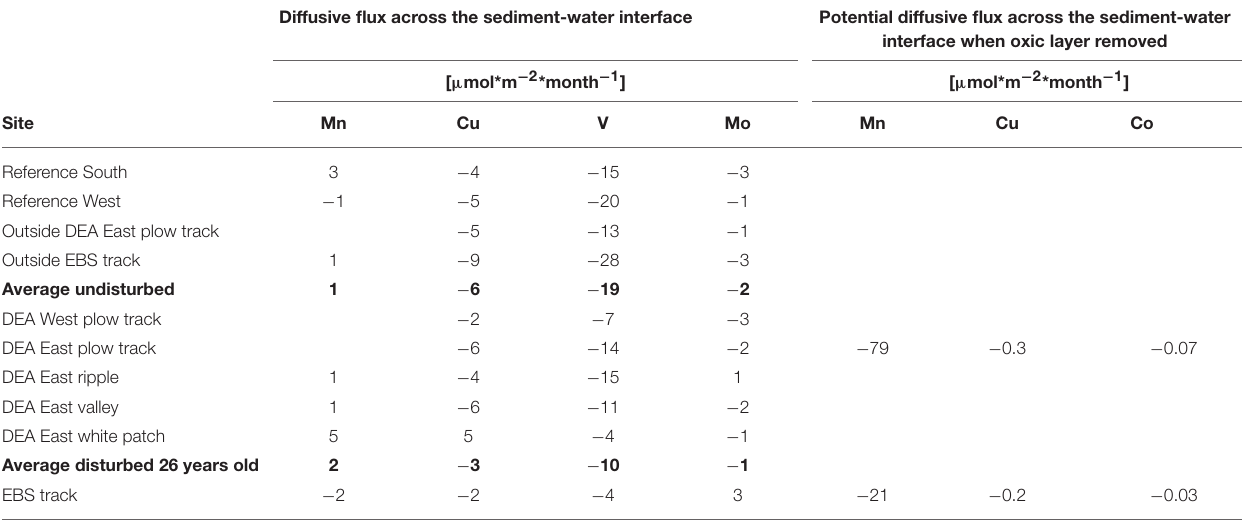
TABLE 3 | Diffusive fluxes of selected dissolved metal ions across the sediment-water interface and potential fluxes across the sediment-water interface when the Mn-oxide rich layer is removed; based on gradients across the redox-boundary in cores from this study. Diffusive flux across the sediment-water interface Potential diffusive flux across the sediment-water interface when oxic layer